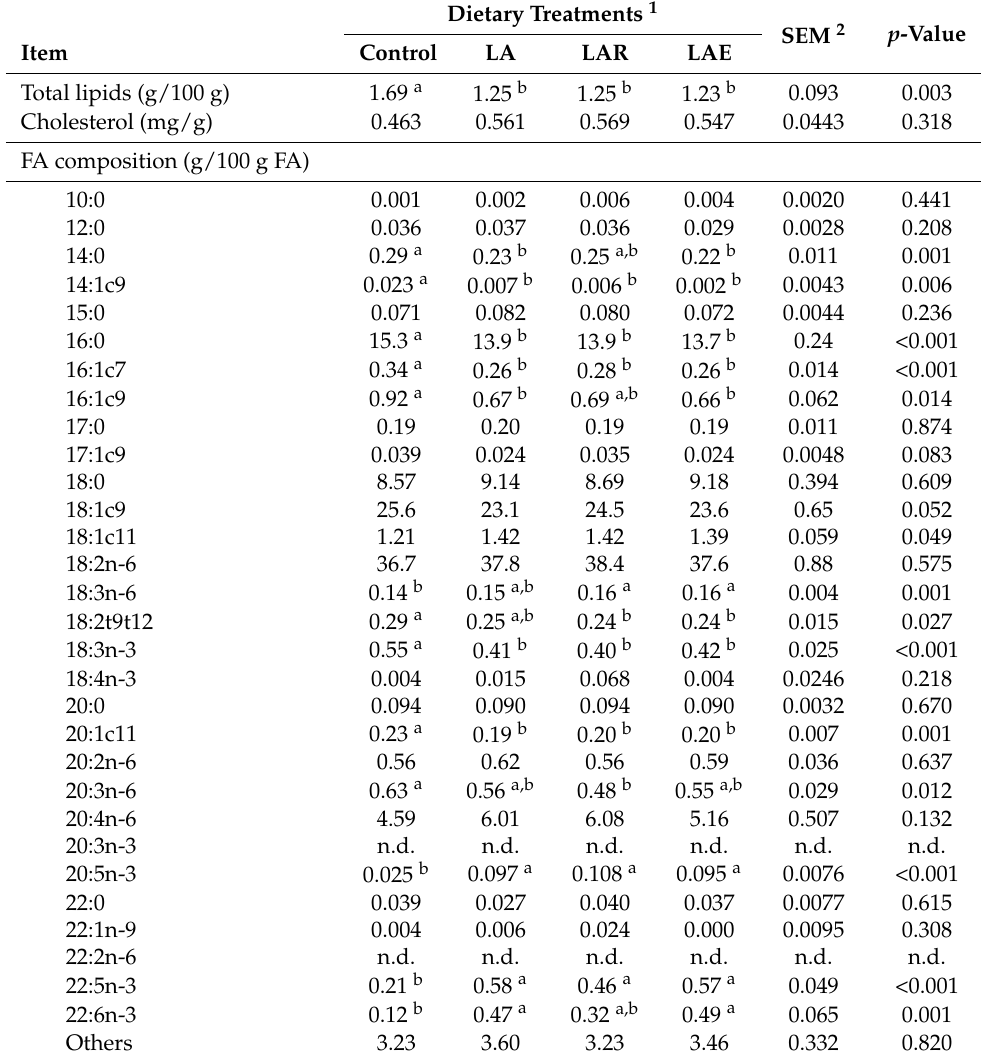
Dietary Treatments 1 SEM 2 p -Value